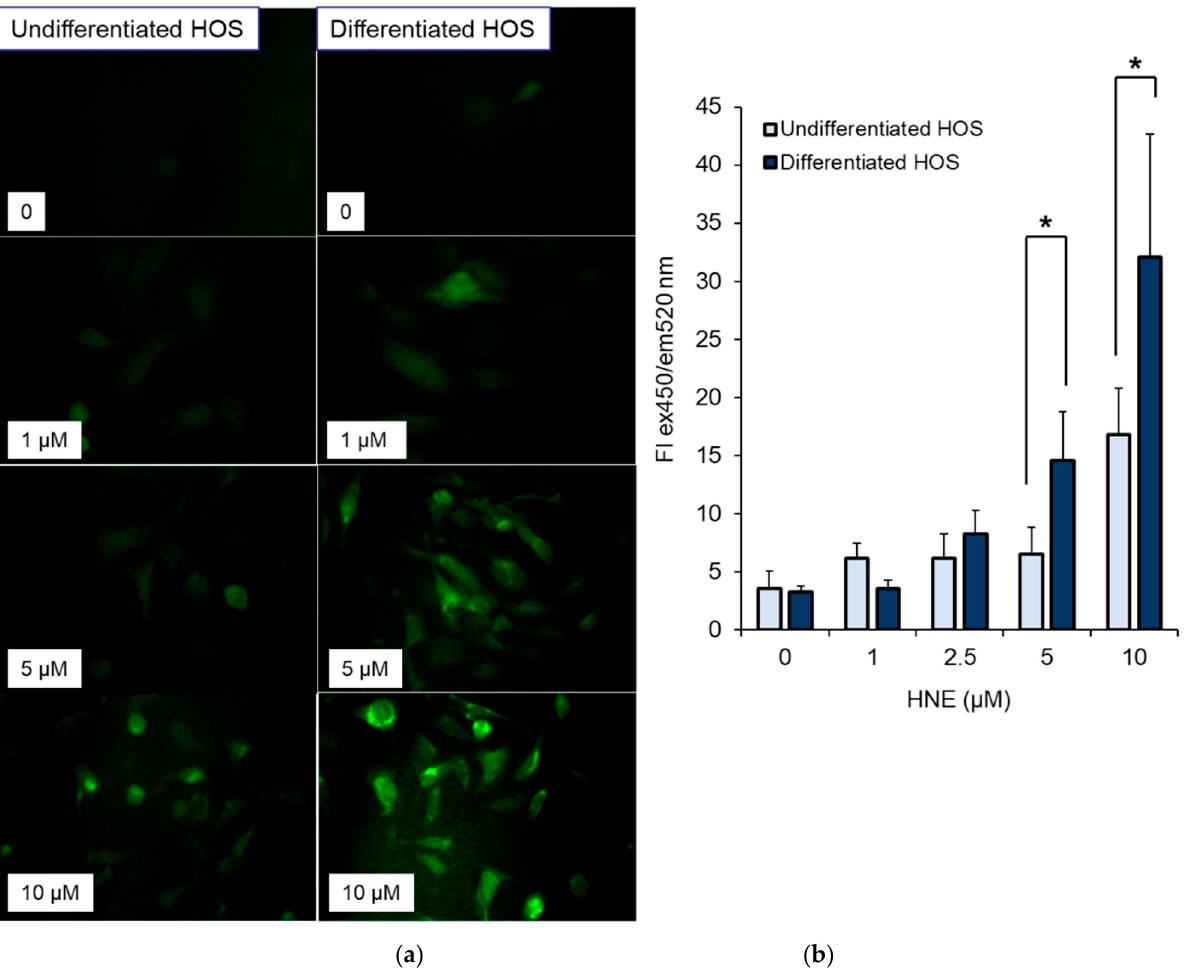
Figure 5. Induction of ROS in cell cultures treated with HNE. ( a ) Green fluorescence as a measure of ROS in differentiated and undifferentiated HOS treated with HNE; ( b ) fluorescence intensity in undifferentiated and differentiated HOS analyzed by t -test, * p < 0.05.